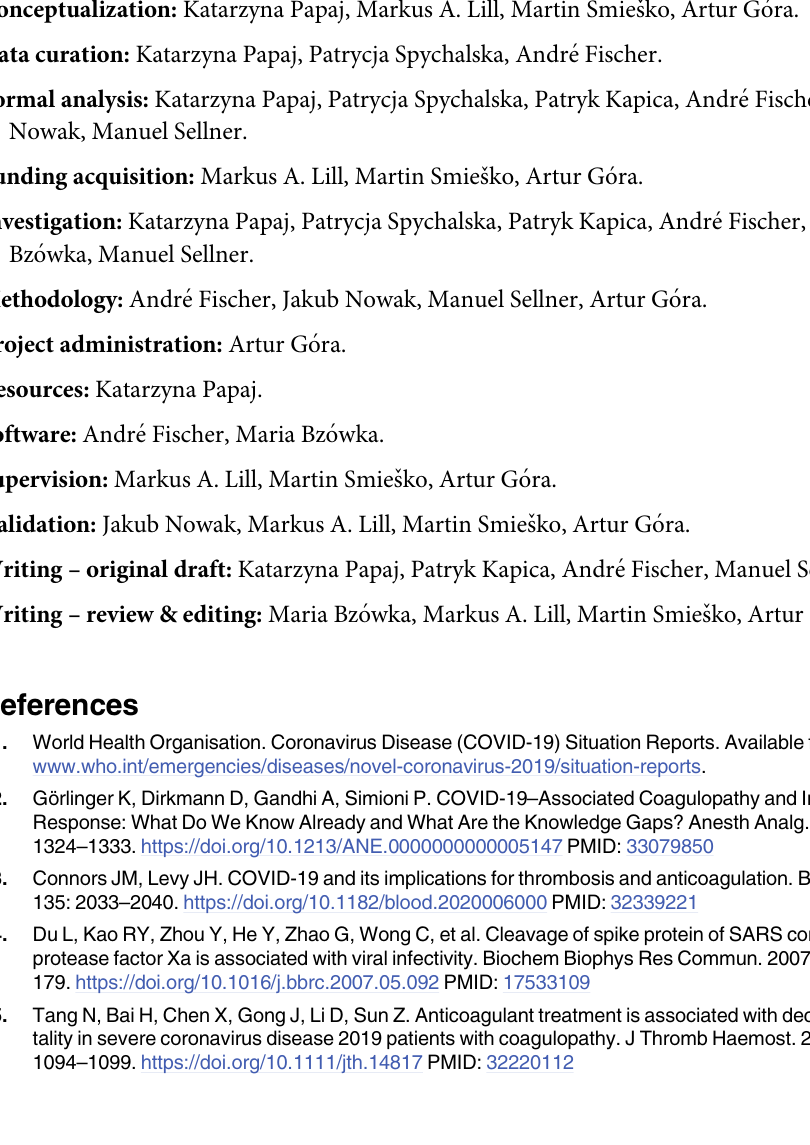
S2 Table. Results from ensemble docking. The percentage indicates how many binding modes could be reproduced with an RMSD below 2.5 Å . S3 Table. The measured melting temperatures of SARS-CoV-2 M pro in a buffer, with dif- ferent DMSO concentration. S4 Table. The measured melting temperatures of SARS-CoV-2 M pro in a buffer with all tested compounds. S5 Table. Results of the in silico evaluation of the analysed